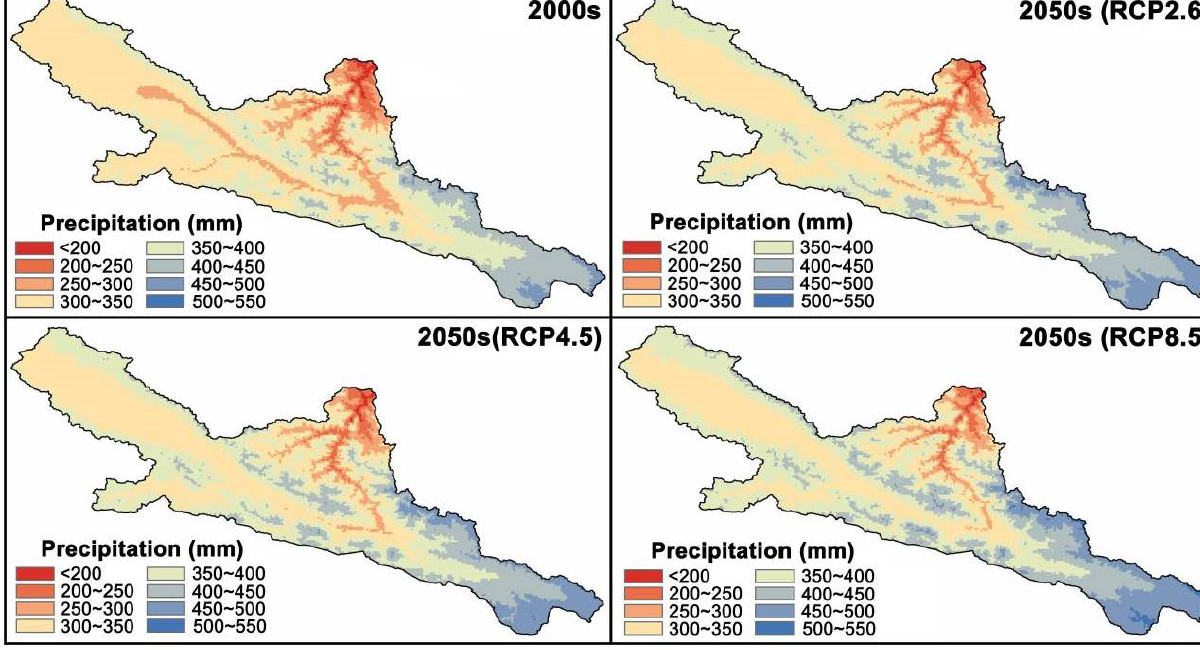
Figure 3. Distribution of mean annual precipitation for the 2000s (1970–2000) and 2050s under the three representative concentration pathways (i.e., RCP2.6, RCP4.5 and RCP8.5) in the study area.